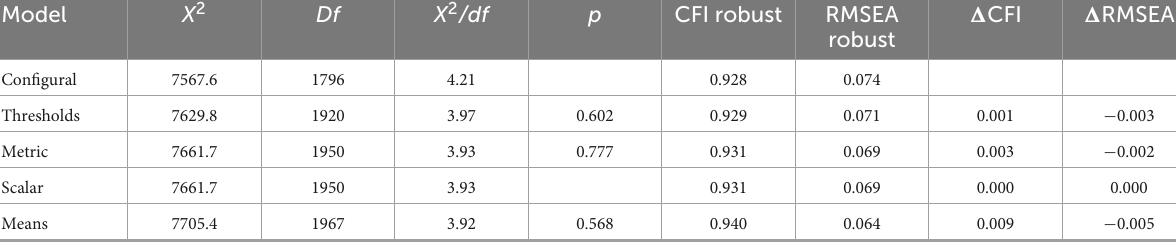
TABLE 5 External validity, through multigroup confirmatory analysis.